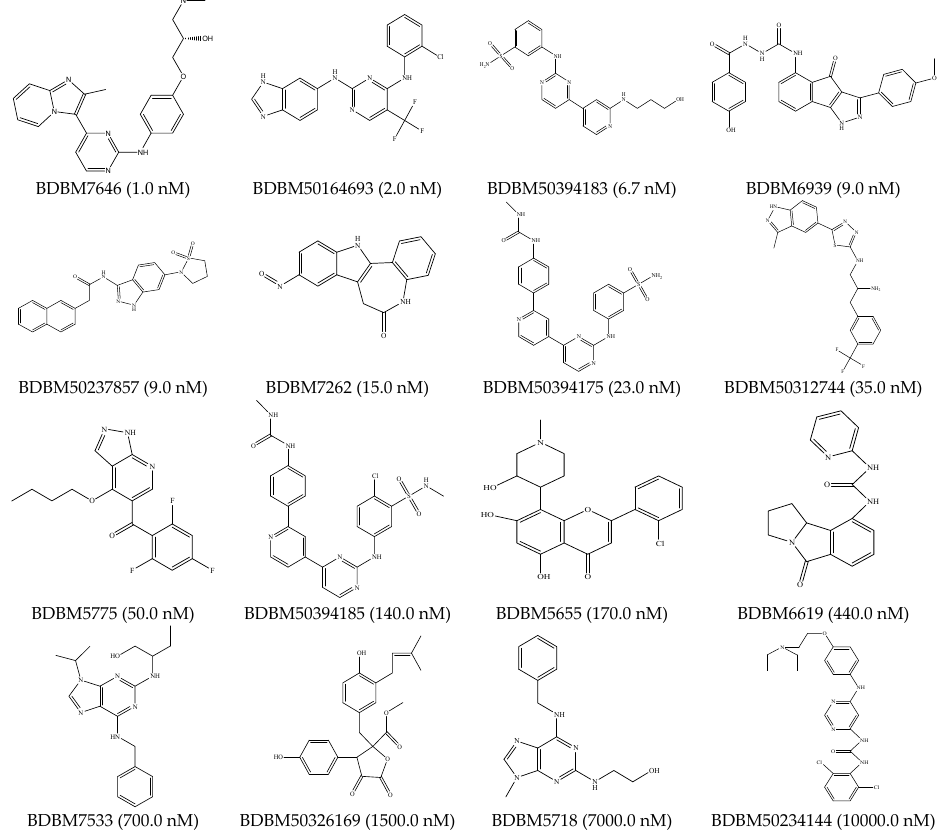
Figure 8. Chemical information of the training set for the HipHop pharmacophore model generation. with MMFF94 partial charge. In order to make the conformation of compounds more close to the active maximum number of the generated compound conformations was set to 255. The relative energy